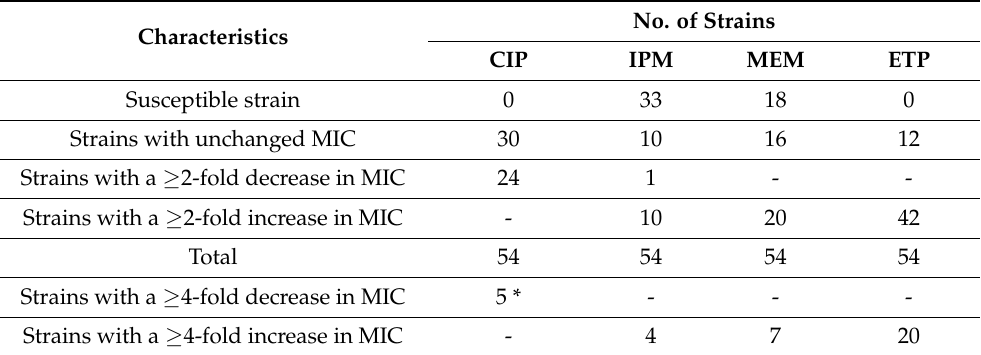
Table 5. Summary of MIC of carbapenem and ciprofloxacin in the presence of PA β N among all 54 NC-CRKP.